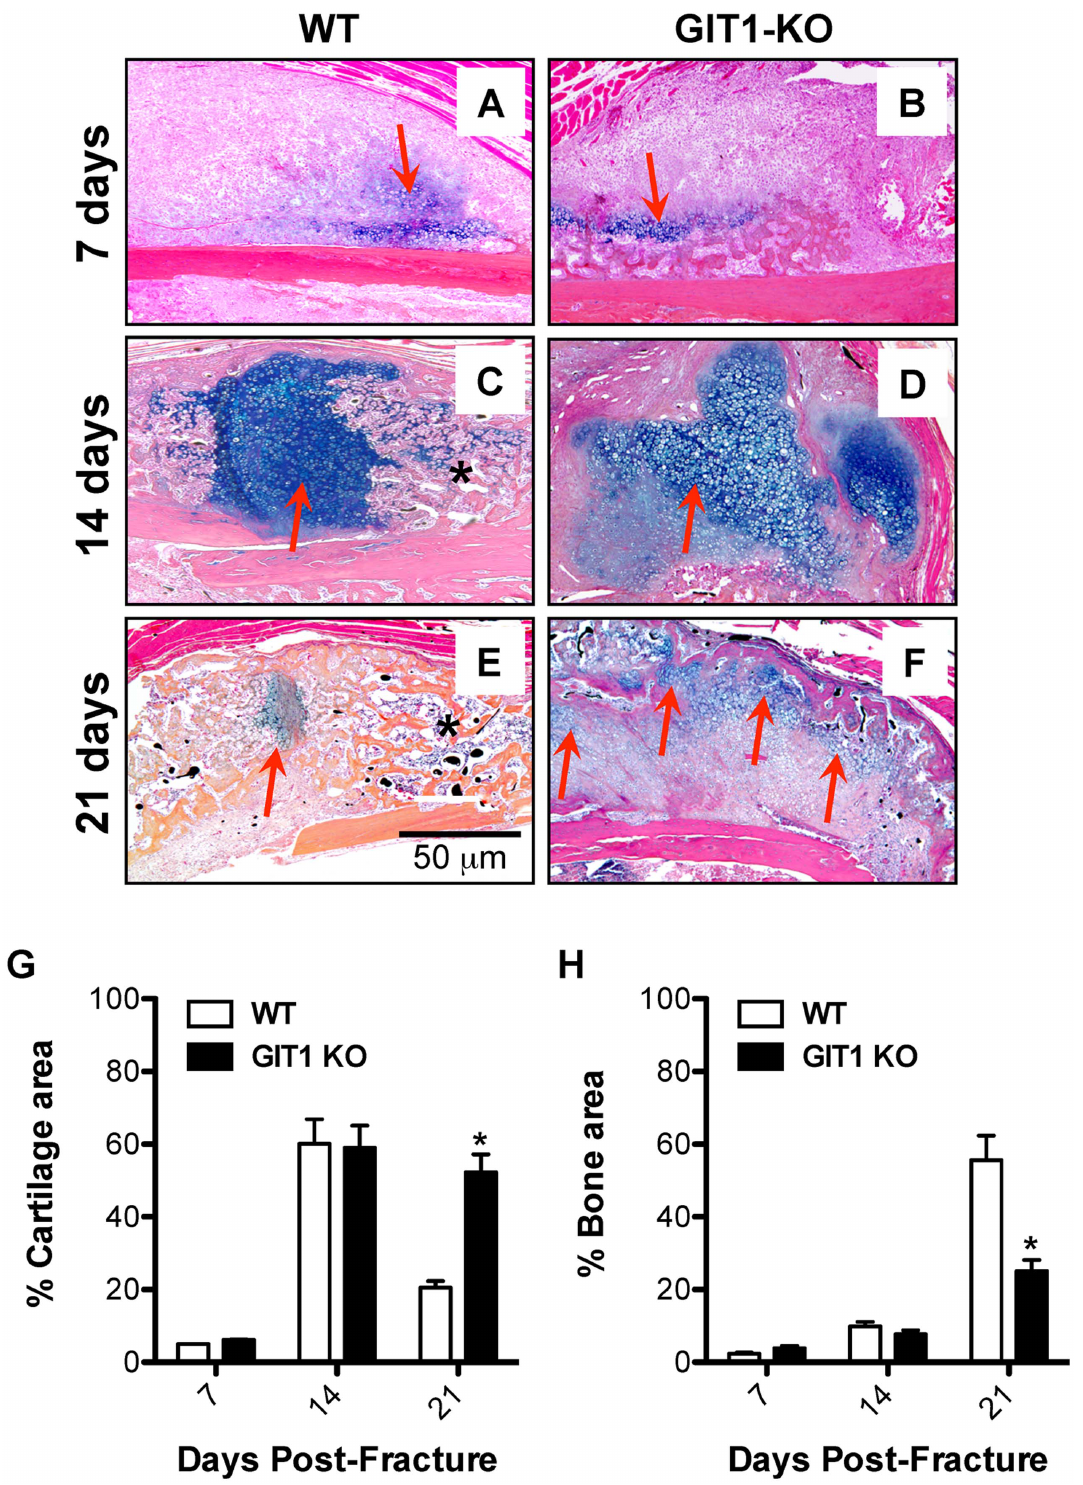
Figure 3. Cartilage persists and woven bone callus is delayed in GIT1 KO mice. Histological analysis of fracture callus cartilage content was performed via Alcian Blue Hematoxylin/Orange G staining. Representative stains of calluses from WT and GIT1 KO mice at 1, 2 and 3 weeks post- fracture are displayed (A–F). Red arrows denote Alcian Blue-stained cartilagenous matrix and asterisks denote mineralized woven bone. Histomorphometry was performed on triplicate sections from multiple mice, with % Cartilage Area (G) and % Bone Area (H) quantified. Bars represent % Area (cartilage or bone) + / 2 SEM (*p , 0.05, N=3).